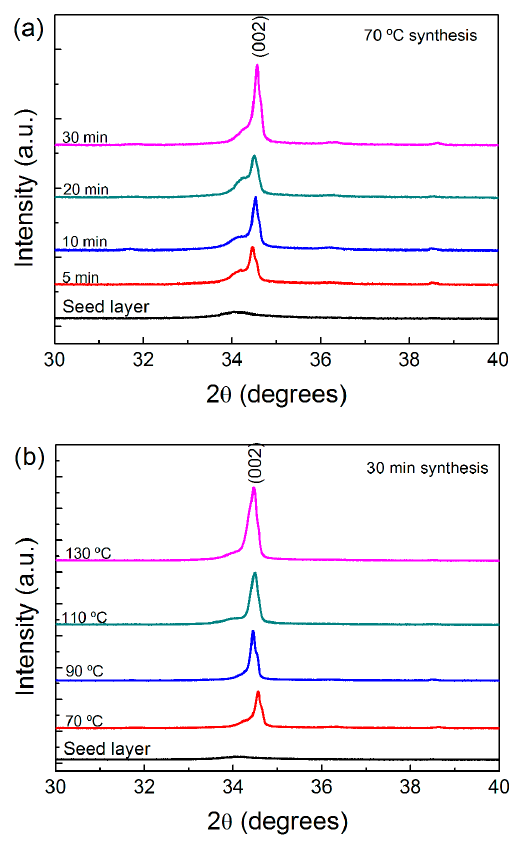
Figure 3. X-ray diffraction (XR)D diffractograms of ZnO nanorod arrays produced by the hydrothermal method assisted by microwave radiation: ( a ) with a temperature of 70 °C for 5, 10, 20 and 30 min; ( b ) for 30 min with a temperature variation between 70 and 120 °C.